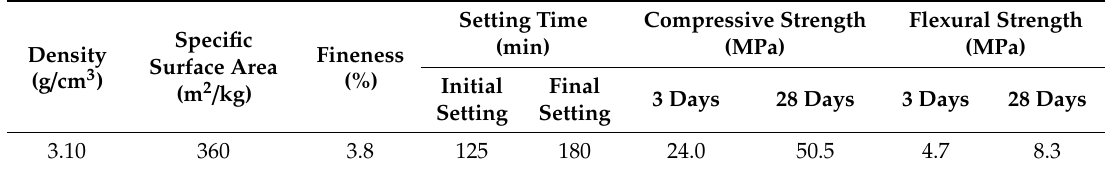
Table 2. Physical and mechanical properties of ordinary Portland cement.